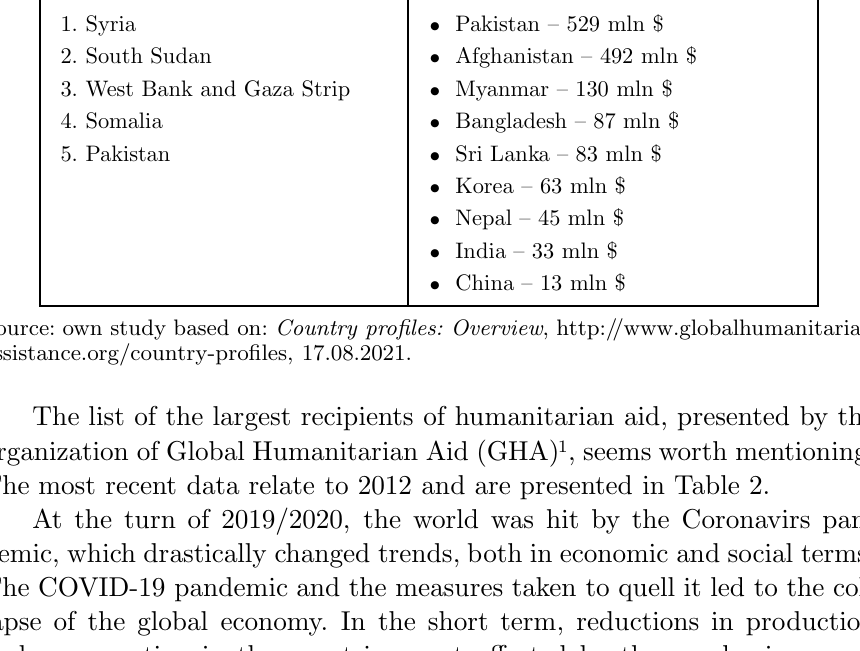
The largest recipients of humanitarian aid in 2015 The largest